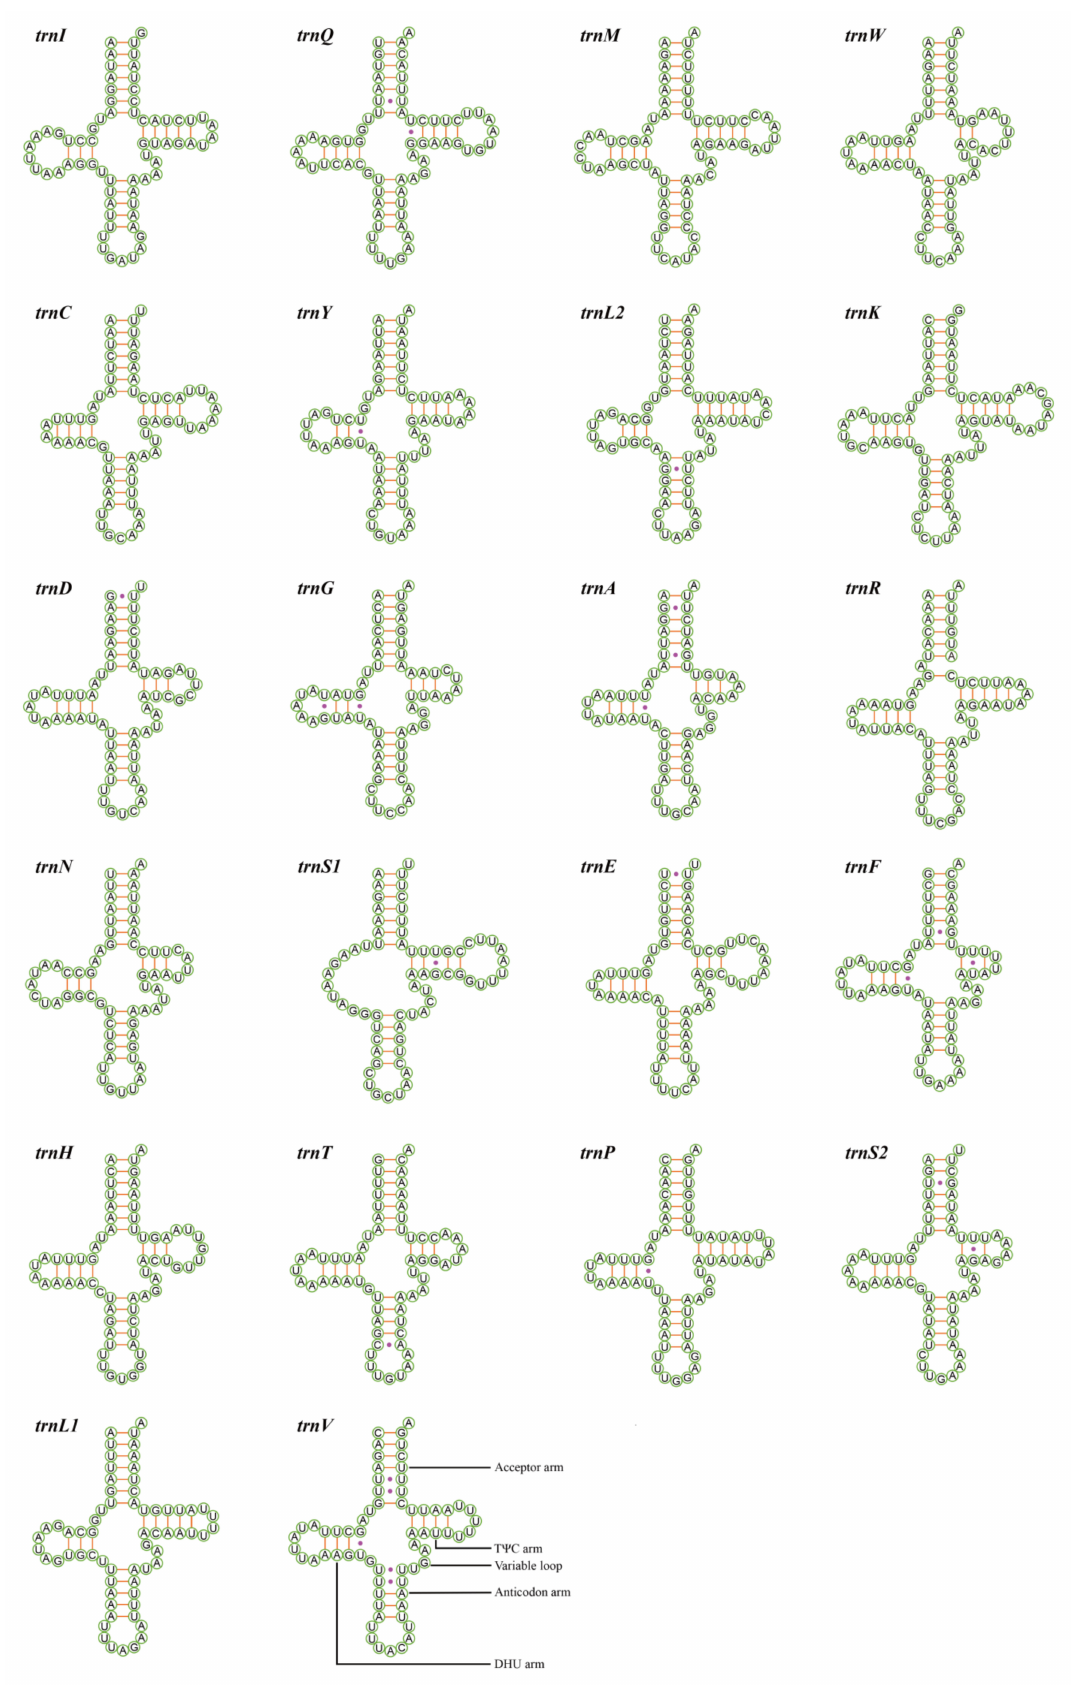
Figure 5. Putative secondary structure for the 22 tRNAs of Ujna puerana